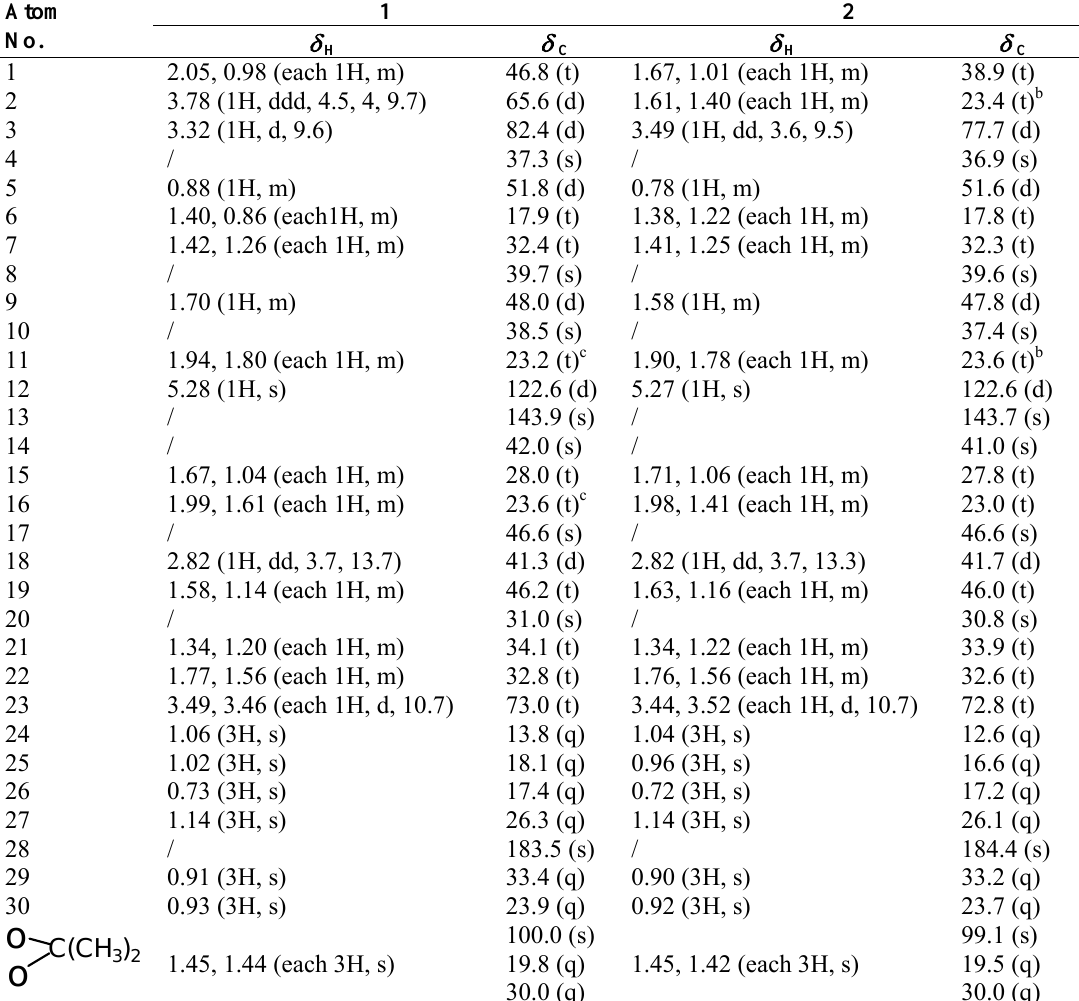
Table 1. The 1 H- and 13 C-NMR spectra data for compounds 1 – 2 ( δ in ppm, J in Hz ) a